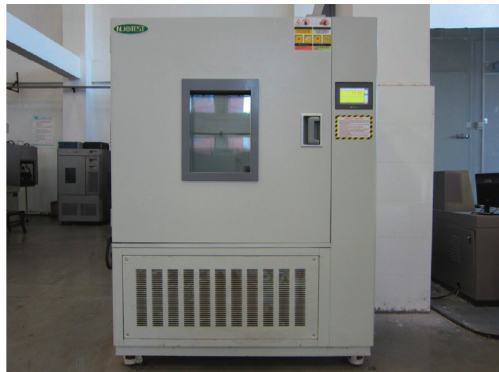
Figure 1: Freezing and thawing cycle test freezing room.